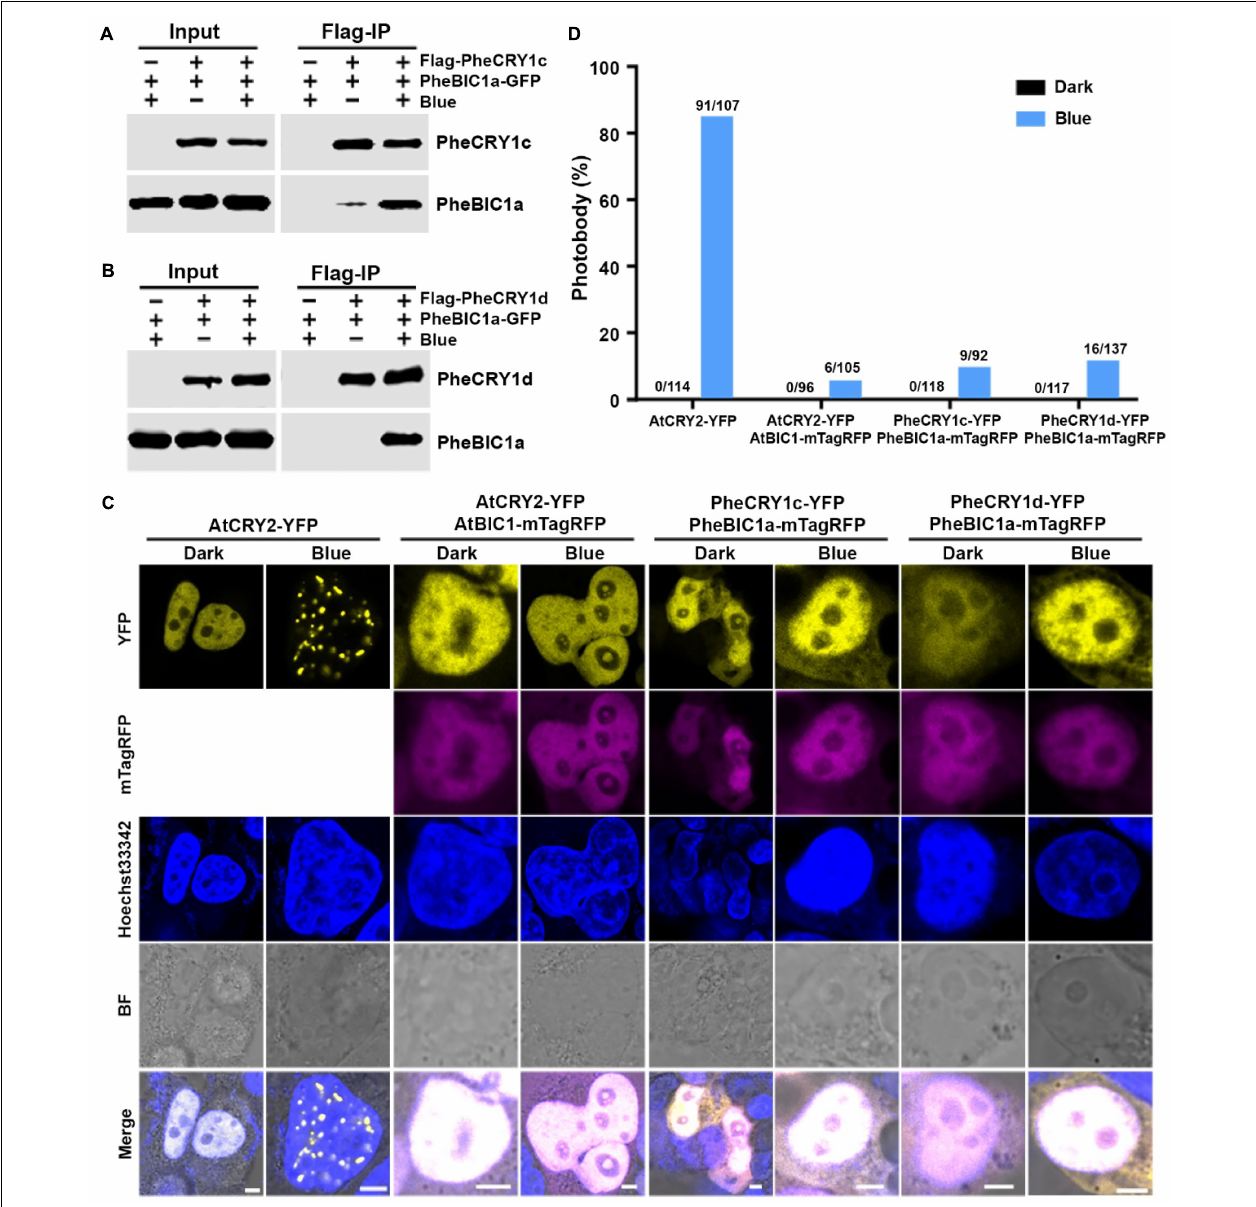
FIGURE 4 | Bamboo PheBIC1 interacts with PheCRY1s to inhibit the photo-oligomerization of PheCRY1. (A,B) Co-immunoprecipitation (co-IP) assays showing the blue light-dependent interaction of PheCRY1 and PheBIC1 in HEK293T cells. Cells co-expressing Flag-PheCRY1 and PheBIC1-GFP were kept in the dark (Blue –) or exposed to 100 µ mol − 2 s − 1 of blue light for 2 h (Blue +). IP were performed with Flag-conjugated beads. The IP and co-IP products were detected with anti-Flag and anti-GFP antibodies, respectively. (C) Confocal images showing the inhibition of PheBIC1 on PheCRY1 photobody formation in HEK293T cells. Cells expressing indicated plasmid pairs were kept in the dark or exposed to blue light (100 µ mol m − 2 s − 1 ) for 1 h. Cells were fixed in 4% formaldehyde before imaging. Hoechst staining shows the nuclei. BF, bright field; scale bar, 5 µ m. (D) Quantitative analysis of the photobody formation in (C) . Photobody (%) is the percent of nuclei with photobodies among counted nuclei. The number of nuclei with photobodies and total counted nuclei was indicated above the